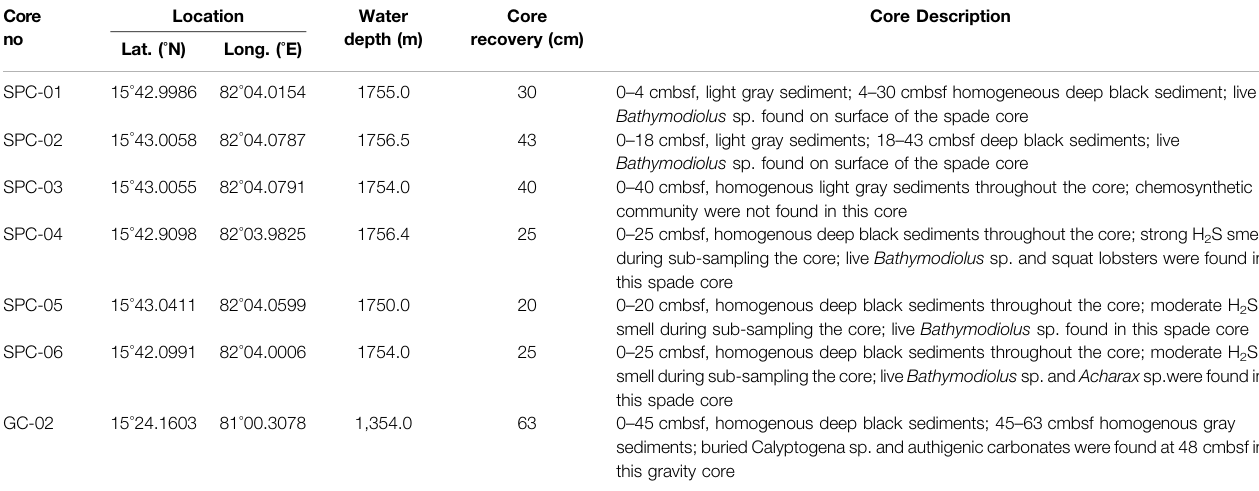
TABLE 1 | Information of spade sediment cores retrieved from an active seep site in the Krishna-Godavari (K-G) basin, Bay of Bengal. Core